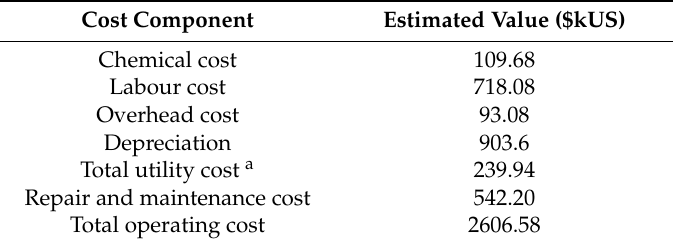
Table 5. Operating cost estimates for the biorefinery process (Equations